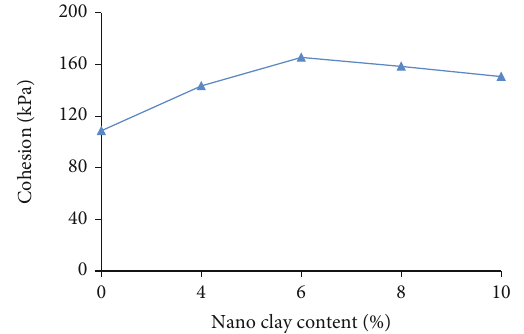
Figure 6: Relationship between nanoclay content and NCCS ’ s